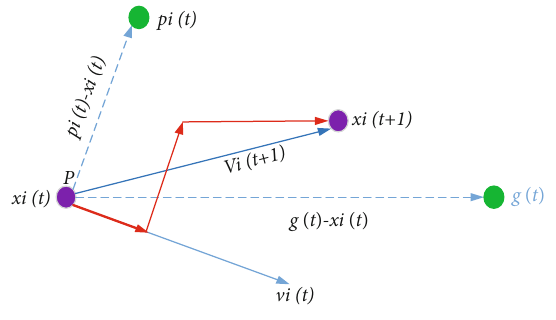
Figure 3: Graphical representation of